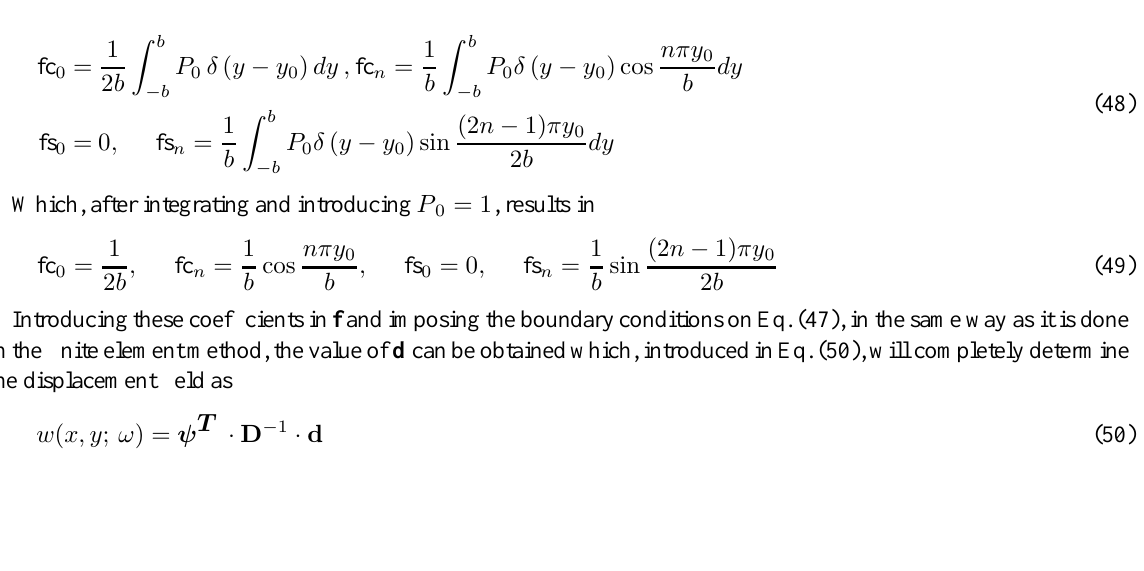
Fig. 5. FRFs obtained with SEM, FEM1 and FEM2 models for a frequency range 14–15